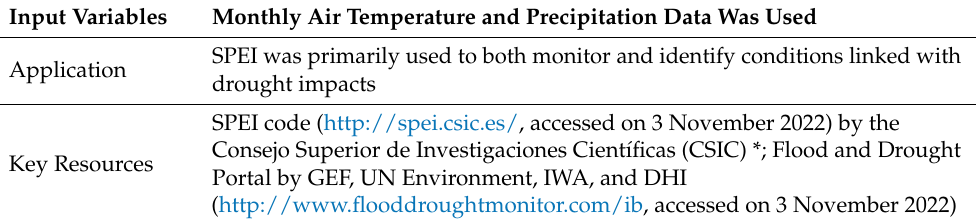
Table 3. The Standardized Precipitation Evapotranspiration Index